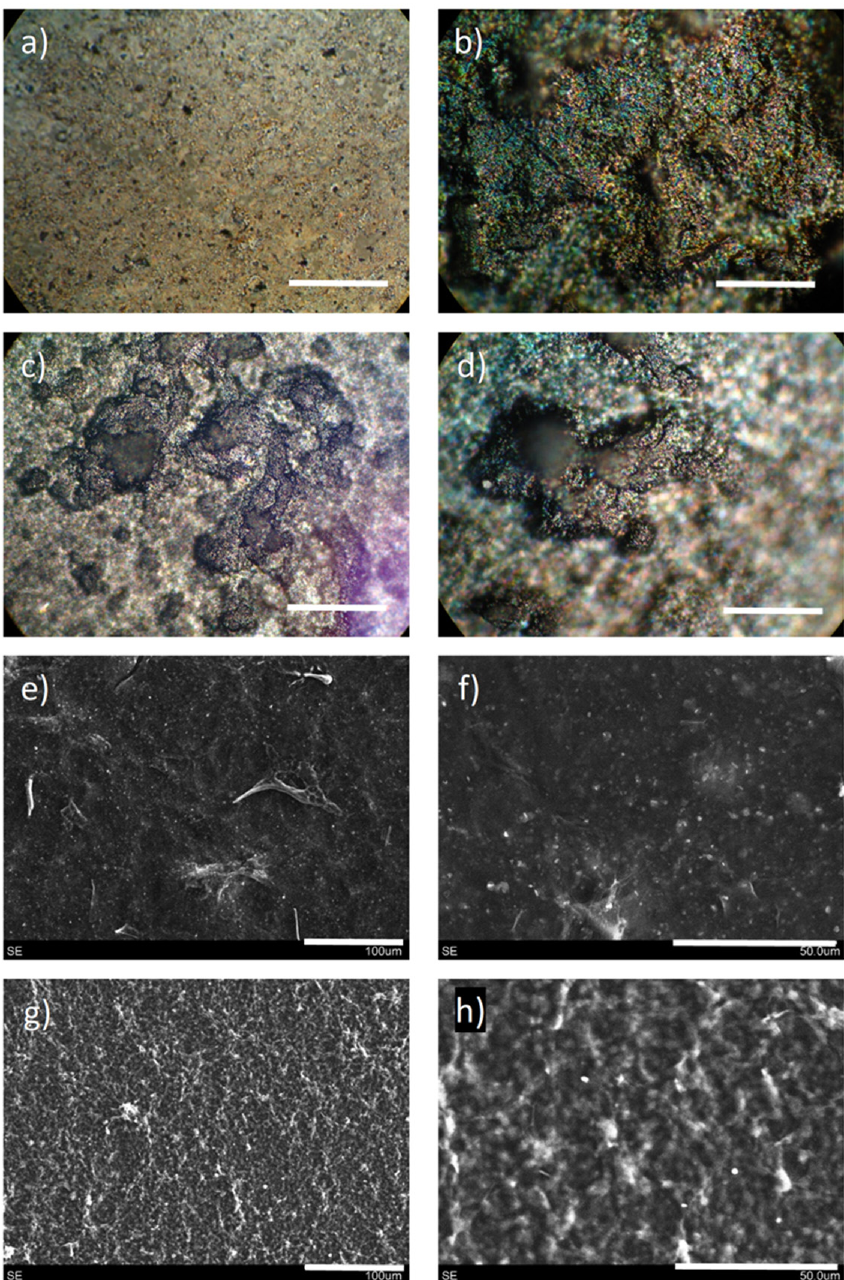
Figure 14. Optical photographs ( a – d ) and SEM images ( e – h ) of films obtained with low-viscosity inks ( a , b , e , f ) and high-viscosity pastes ( c , d , g , h ). Scale bars (in white) = 1 mm ( a , b ), 400 µm ( c , d ), 100 µm ( e , g ), and 50 µm ( f , h ). Each image (either optical or from SEM) corresponds to a random point of each sample, none is the direct magnification of another. Used with permission from ref. [70].